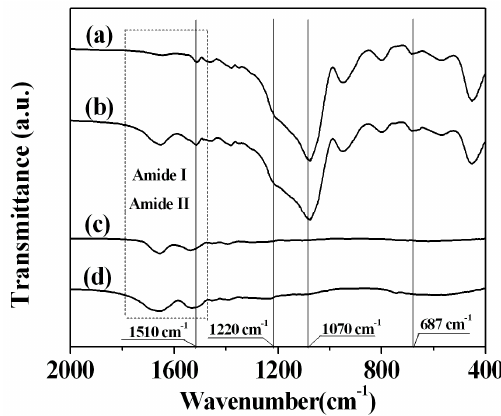
Figure 4. Fourier transform infrared (FTIR) spectrum of NH 2 -Silica ( a ); the co-immobilised enzymes ( b ); lysozyme ( c ); and β -galactosidase ( d ).